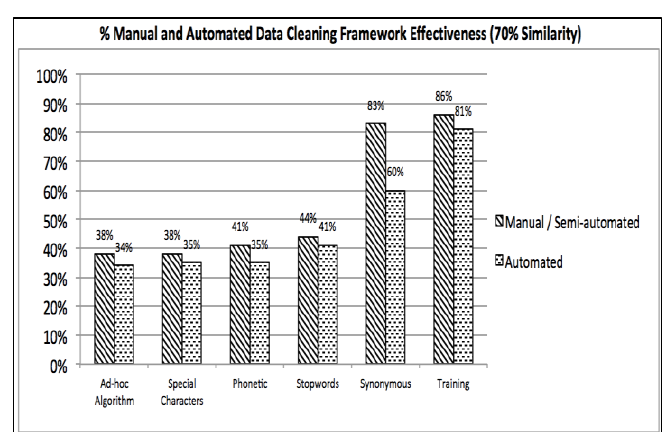
Figure 7: Manual and automated data cleaning environment effectiveness with 70%